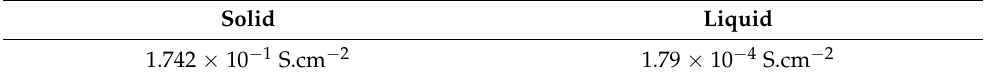
Table 2. Composite membranes conductivity comparison in solid and liquid